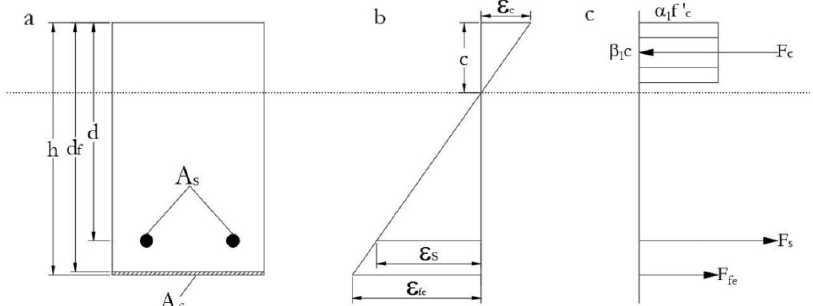
Figure 2. a) Cross section for the model adopted of bending with action of the collaborating form. b) Diagram of deformations of the beam c) Diagram of balance of internal forces acting on the beam in